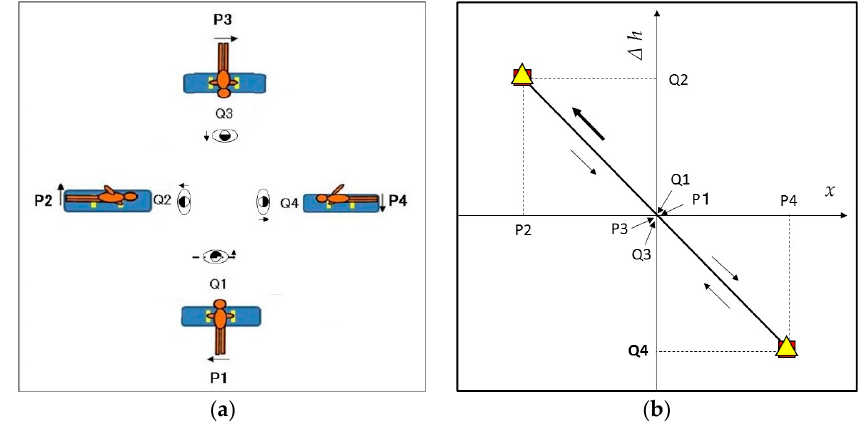
Figure 1. ( a ) Performance of double-leg circle ( b ) Lissajous diagram from the ideal geometrical point of